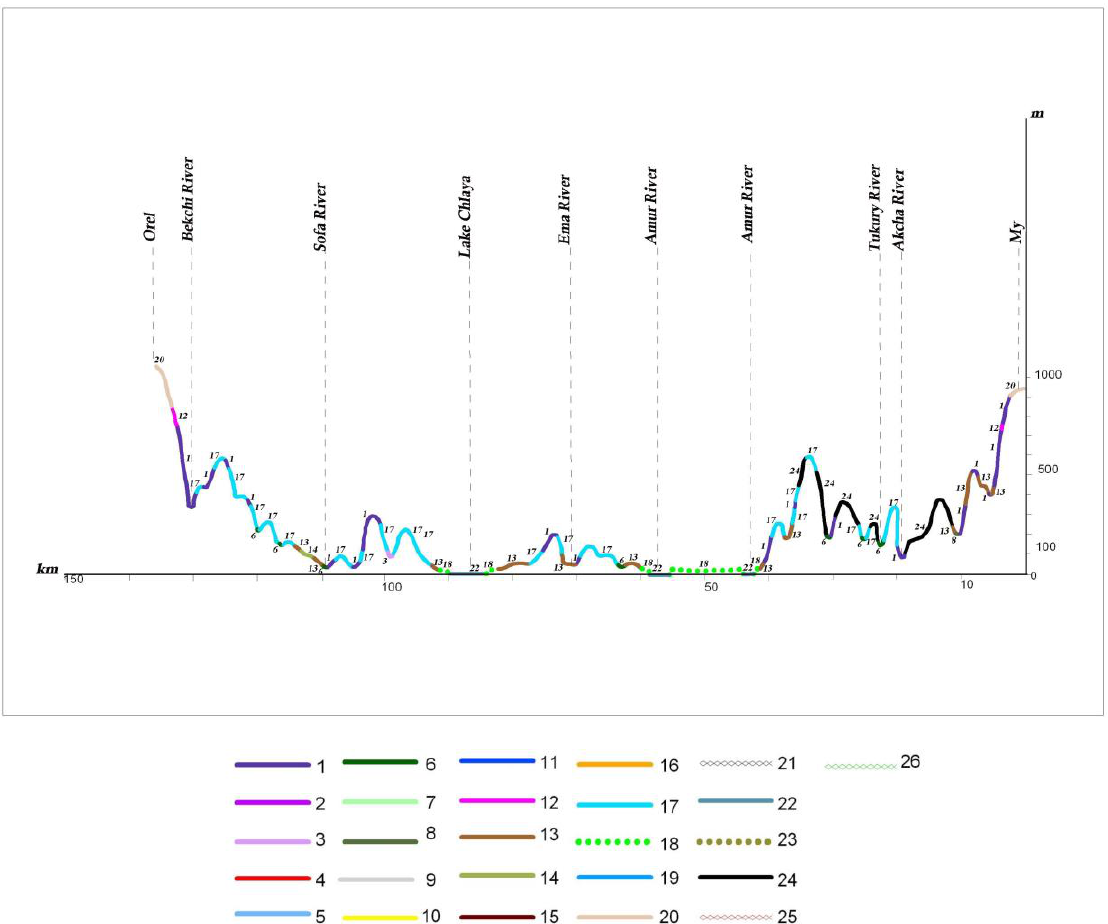
Figure 10. Profiles of plant cover from the mountain My to the mountain Orel (III): 1 — spruce and fir – spruce green moss, small herb – green moss mountain forests and subalpine sparse forests in some places combined with stone birch forests; 2 — spruce and fir – spruce green moss, small herb – green moss, green moss – fern mountain forests; 3 — fir – spruce – green moss – fern and herb – fern with nemoral elements in the cover and undergrowth of the slopes of mountain and submontane forests in some places, with Pinus koraiensis and broadleaf species; 4 — Korean pine – broadleaf shrub – mixed herb, shrub – mixed herb – fern, liana – mixed herb – fern mountain and submontane forests, in some places combined with coniferous species; 5 — mixed (polydominant) broadleaf mountain and submontane secondary forests in situ of the Korean pine broadleaf forests; 6 — the range of willow stand – chosenia – poplar floodplain vegetation in some places combined with broadleaf elm – ash valley forests; 7 — the range of willow stand – chosenia – poplar floodplain vegetation in some places combined with fir – spruce green moss, herb and herb – shrub valley forests; 8 — the range of willow stand – alder – poplar floodplain vegetation in some places combined with shrub thickets and meadows; 9 — oak submontane, mountain forests with participation by other broadleaf species; 10 — oak forests with participation by other broadleaf species, sparse shrub thickets on the alluvial floodplain terraces, eolian ridges; 11 — stone birch herb subalpine forests; 12 — creeping dwarf pine and dwarf alder subalpine forests, in some places combined with mountain tundra; 13 — larch ledum, herb – dwarf shrub mountain forests; 14 — fen, swamp, bogs combined with larch shrubby birch – sphagnum, oligotrophic dwarf shrub, shrub – sphagnum, sedge – sphagnum waterlogged forests and sparse forests, shrubby birch and willow stand waterlogged thickets on the floodplain and marine terraces; 15 — larch green moss – ledum, herb valley forests and sparse forests; 16 — larch mesophyllus herb – shrub forests with participation by the nemoral elements in the herb cover and slope in some places combined with oak and black birch; 17 — white birch herb secondary valley and submontane forests in situ with larch and fir – spruce forests, in some places combined with shrubby birch thickets and meadows; 18 — white birch and aspen herb, herb – shrub secondary mountain, submontane forests in situ Korean pine broadleaf, fir – spruce forests in some places combined with mixed broadleaf, oak – white birch forests, sparse forests and shrub thickets;